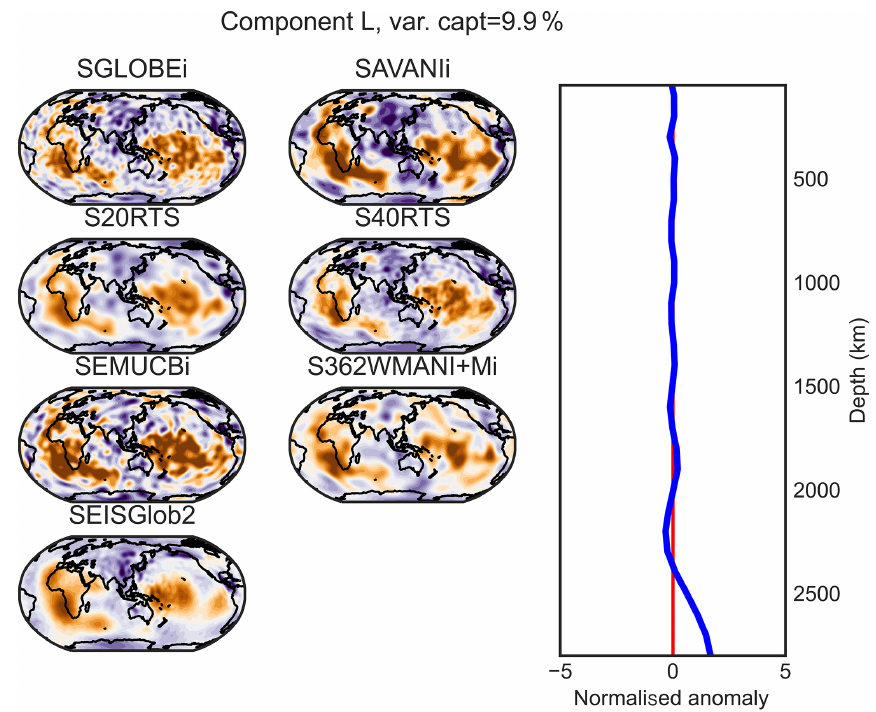
Figure D11. PC L (maximum at 2800km of depth) of the combined analysis of the isotropic parts of the models.